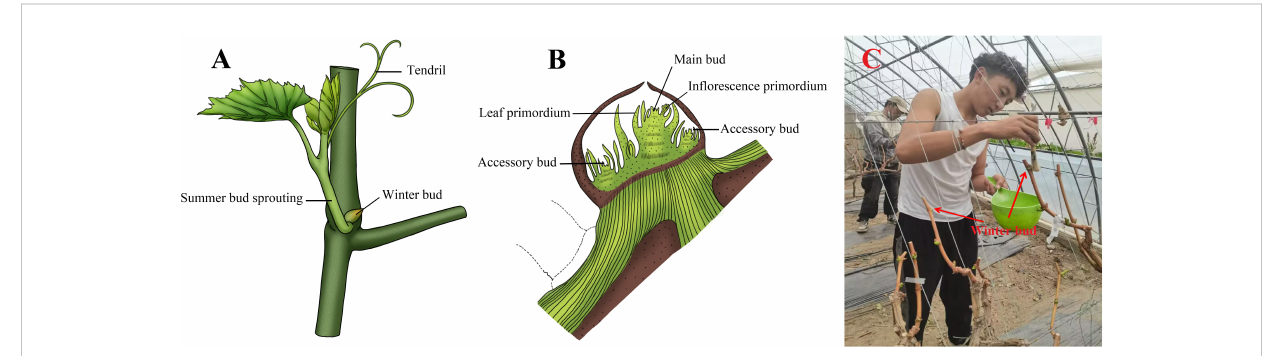
FIGURE 2 Grapevine growth diagram (A) , winter bud structure pro fi le (B) and pruning after the harvesting of primary fruit and application of bud-breaking chemicals near the top fi rst and second winter buds (C)